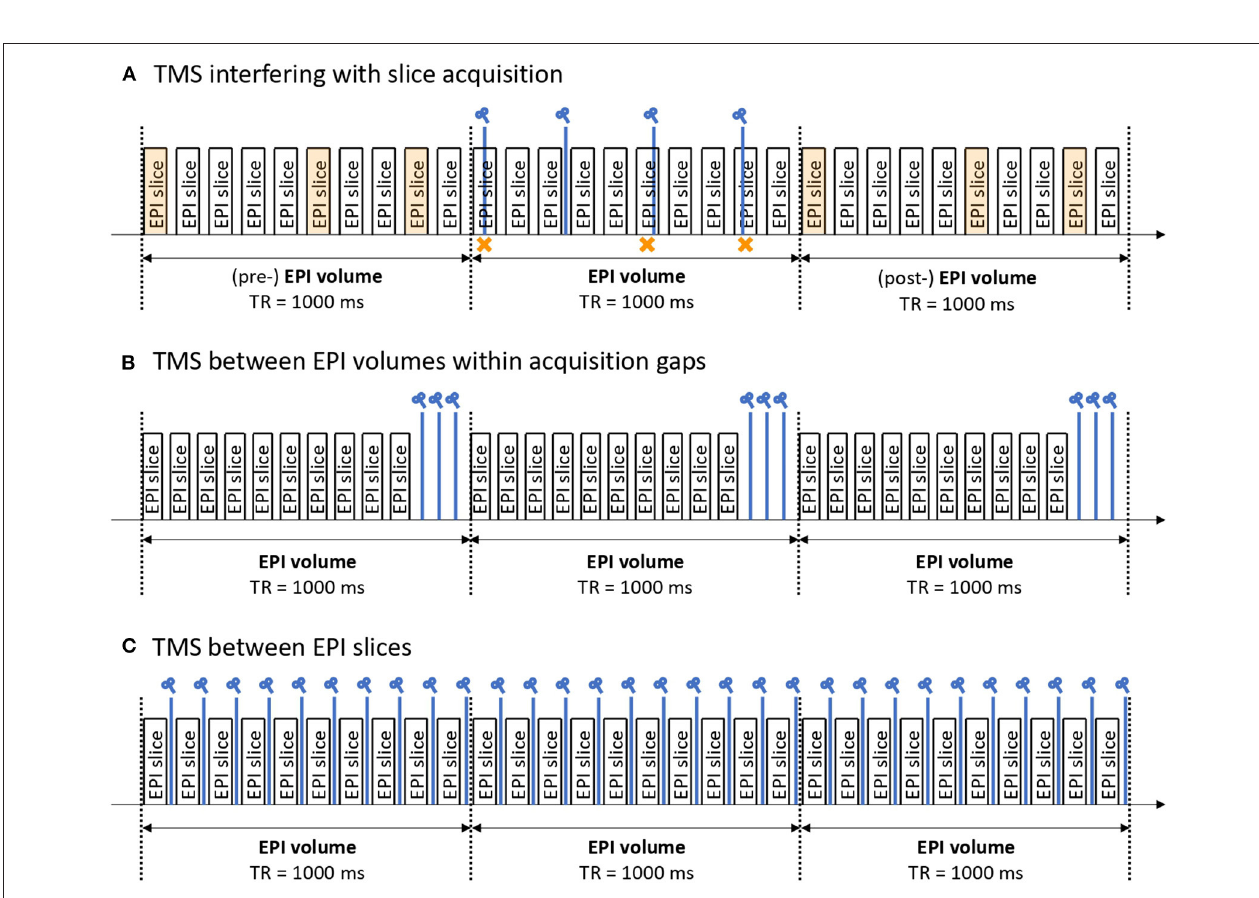
FIGURE 2 | Example of concurrent TMS-fMRI protocols. There are three possible ways to apply TMS pulses during fMRI simultaneously. (A) A method enabling TMS to interfere with EPI slices. Perturbed EPI slices (indicated by an orange cross) are sacrificed and replaced by slice interpolation, typically from the volumes before and after the volume of interest (indicated by orange EPI slices). Advantages: High flexibility to stimulate at any time regardless of EPI timing. Disadvantages: It requires a high level of post-processing capabilities to detect the damaged EPI slices and replace them. (B) A method to insert a gap time between EPI slices and apply TMS pulses meanwhile. Advantages: No EPI slices are sacrificed. Disadvantages: The number of stimulations is limited as it needs to fit in the gap time. Hence, the whole TMS-fMRI protocol tends to be longer. (C) A method to interleave TMS pulses with EPI slices. Advantages: It allows for continuous stimulation which is often used as a therapeutic protocol. Disadvantages: Reliable hardware and software are essential as the pulses must be controlled